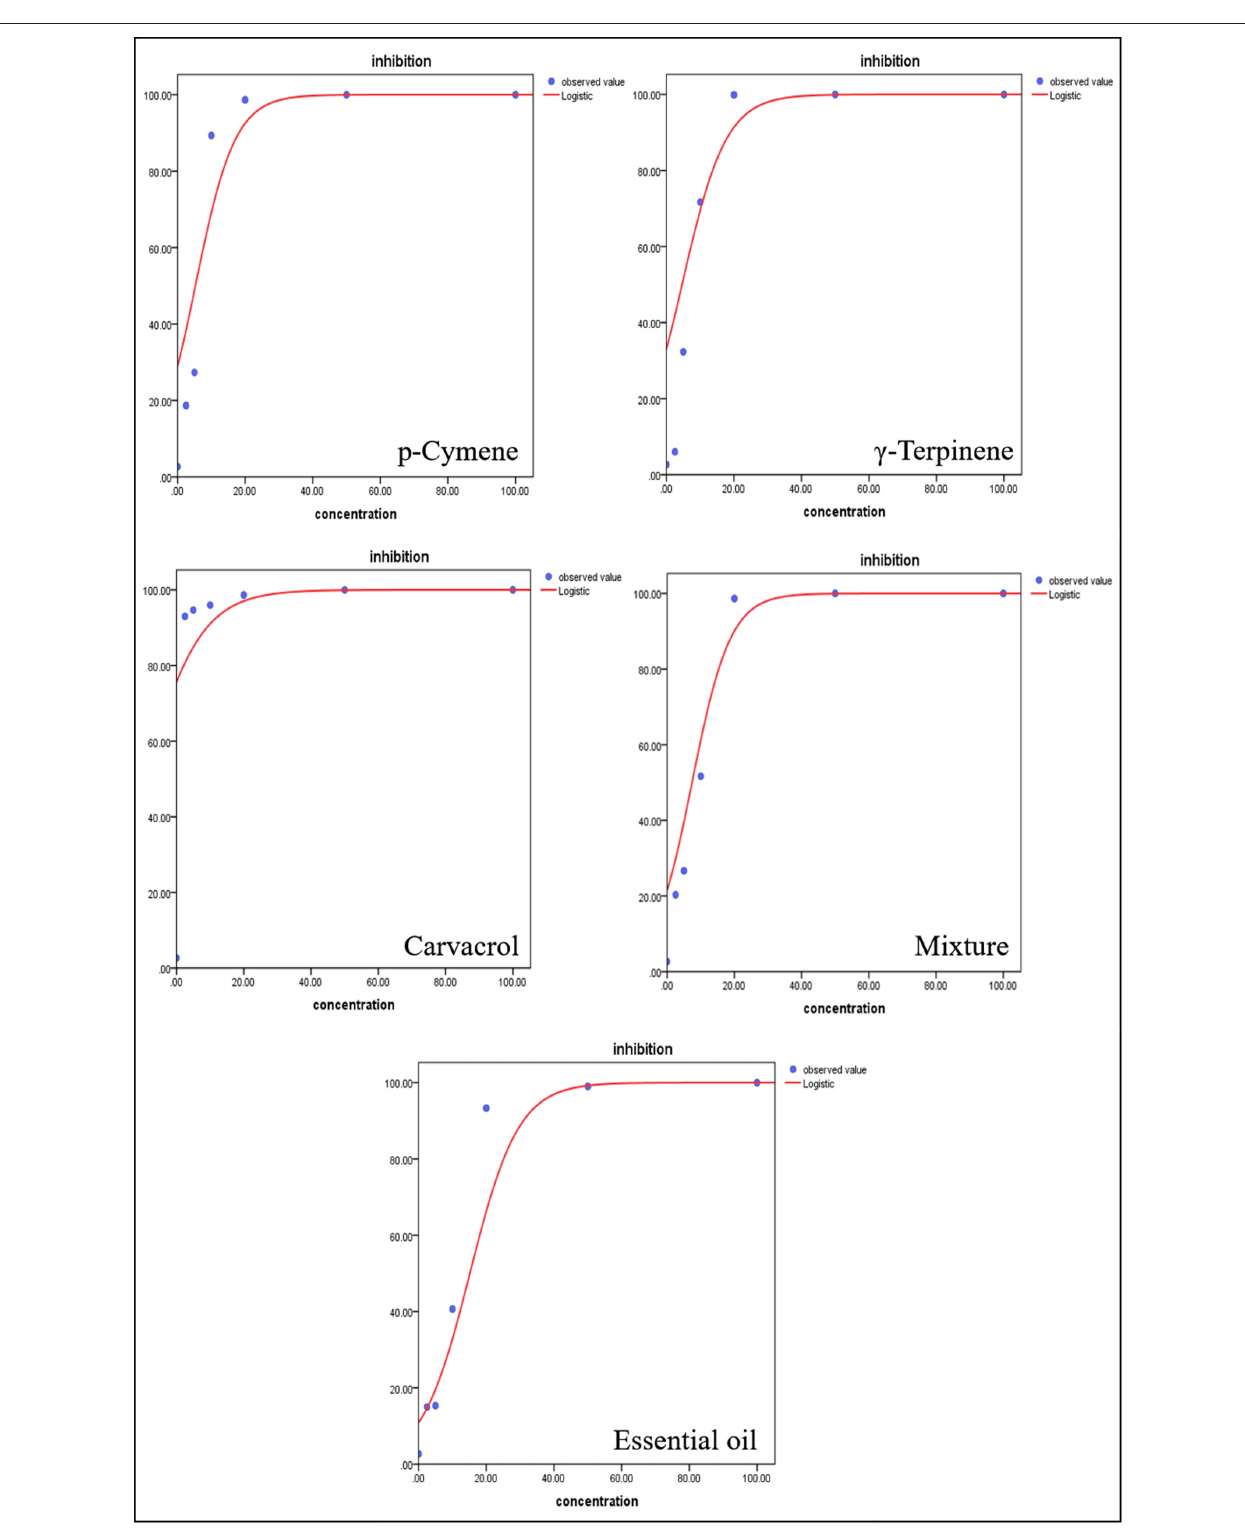
Frontiers in Plant Science |